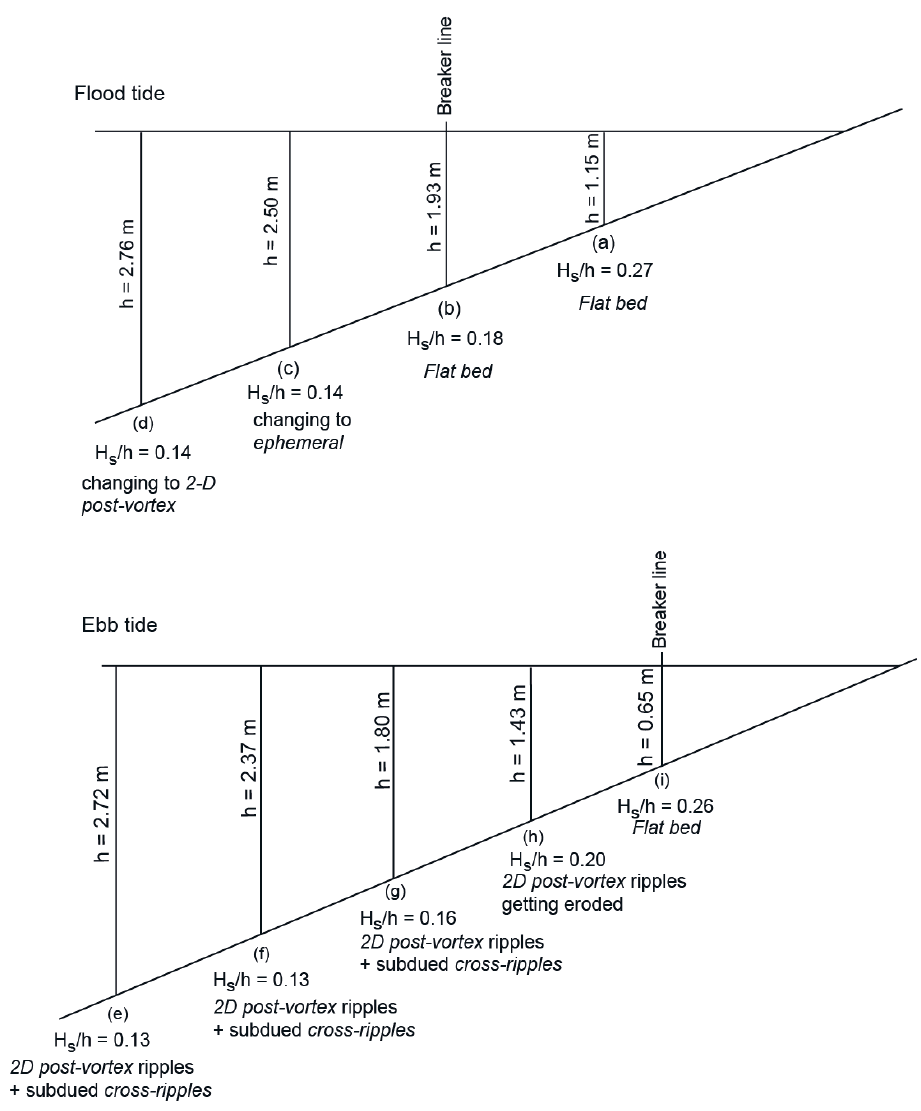
Figure 7. Schematic diagram of the beach face and the positioning of the instrument station with respect to the varying water level due to the tidal cycle, Cable Beach, Broome, Western Australia. The instrument station was maintained at one place, whilst the water level changed due to the tide. Note the different scales along the y